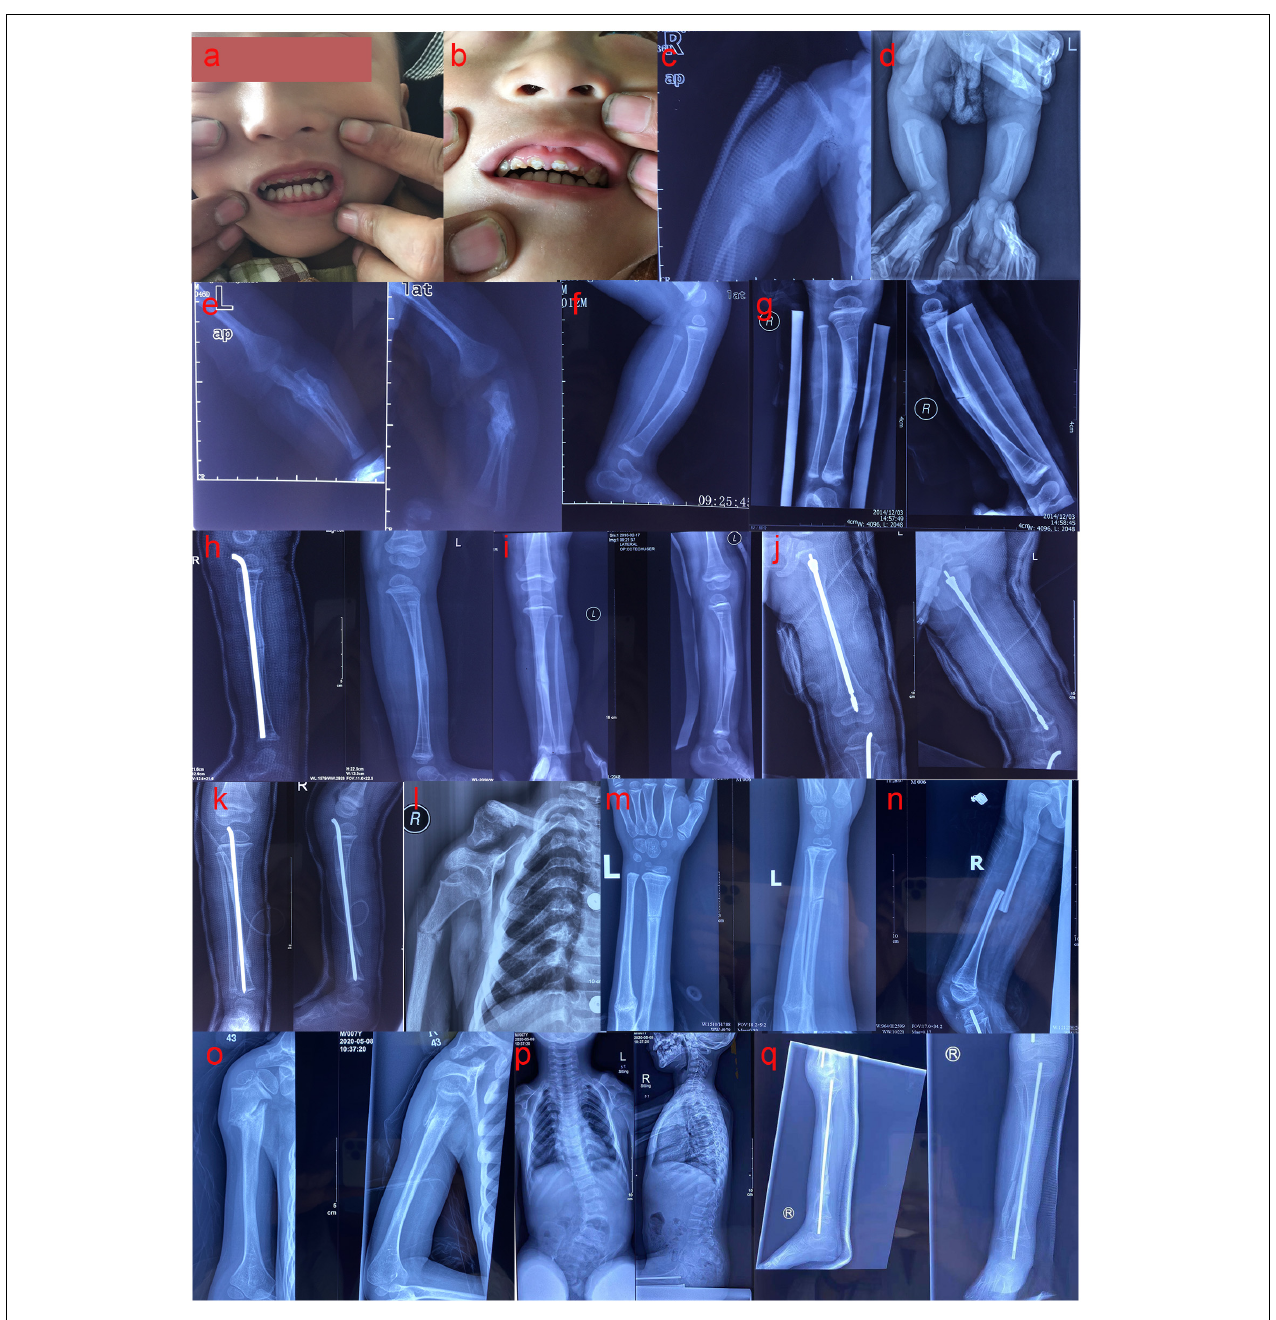
FIGURE 1 | (a,b) The enamel of the left and right central incisors, lateral incisors, and canines of the proband’s maxilla were evidently exfoliated, showing a brownish-yellow appearance; the abovementioned teeth were severely worn, and some were close to the gingival margin. (c) Anteroposterior radiograph (AP) of the right humerus at 1 month after birth: fracture of the right humerus. (d) AP of both lower limbs at 1 month after birth: fracture of the right tibia. (e) The anteroposterior and lateral radiographs of the left ulna and radius at 1 month after birth: fracture of the left ulna and radius. (f) Lateral radiographs of the left tibia and fibula at the age of 1 year: left tibia fracture. (g) The anteroposterior and lateral radiographs of the right tibia and fibula at 1 year and 11 months: fracture of the right tibia. (h) Bilateral tibia and fibula lateral radiographs at 2 years old: the right upper tibia fractured when the right middle tibia fracture was fixed with intramedullary rod internal fixation, and combined with the left tibia fracture. (i) The anteroposterior and lateral radiographs of the left tibia and fibula at 3 years and 1 month: fracture of the left tibia. (j) The anteroposterior and lateral radiographs of the left femur at 3 years and 2 months: multiple fractures of the left femur. (k) The anteroposterior and lateral radiographs of the right tibia and fibula at 3 years and 3 months: multiple fractures of the right tibia. (l) AP of the right humerus at 5 years and 7 months: right humerus fracture. (m) The anteroposterior and lateral radiographs of the left ulna and radius at 6 years and 8 months: fracture of the left ulna and radius. (n) Lateral radiograph of the right femur at 6 years and 9 months: fracture of the right femur. (o) The anteroposterior and lateral radiographs of the right humerus at 7 years and 4 months: fracture of the right humerus. (p) The anteroposterior and lateral radiographs of the whole spine showed severe scoliosis at 7 years and 4 months. (q) The anteroposterior and lateral radiographs of the right tibia and fibula at 7 years and 10 months: multiple fractures of the right tibia and fibula.